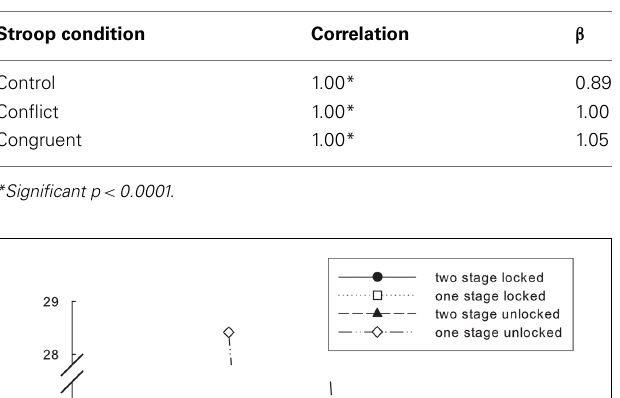
Table 4 | Fit of Piéron’s law against simulation data for both two stage and one stage models with unlocked inputs.